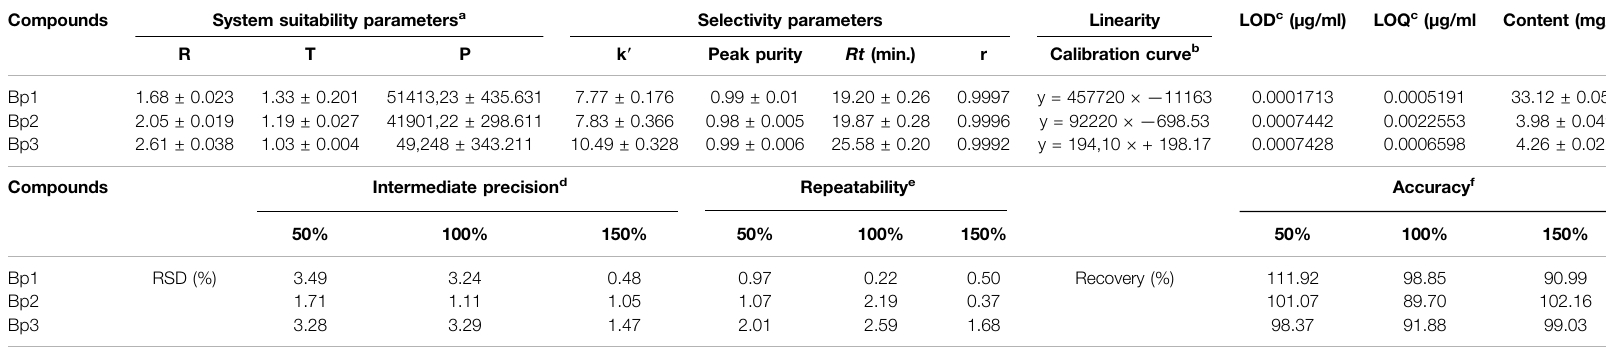
TABLE 1 | Validation parameters of the analytical method to quantify the content of Bp1, Bp2, and Bp3 in B. pinnatum extract at UV 340 nm.